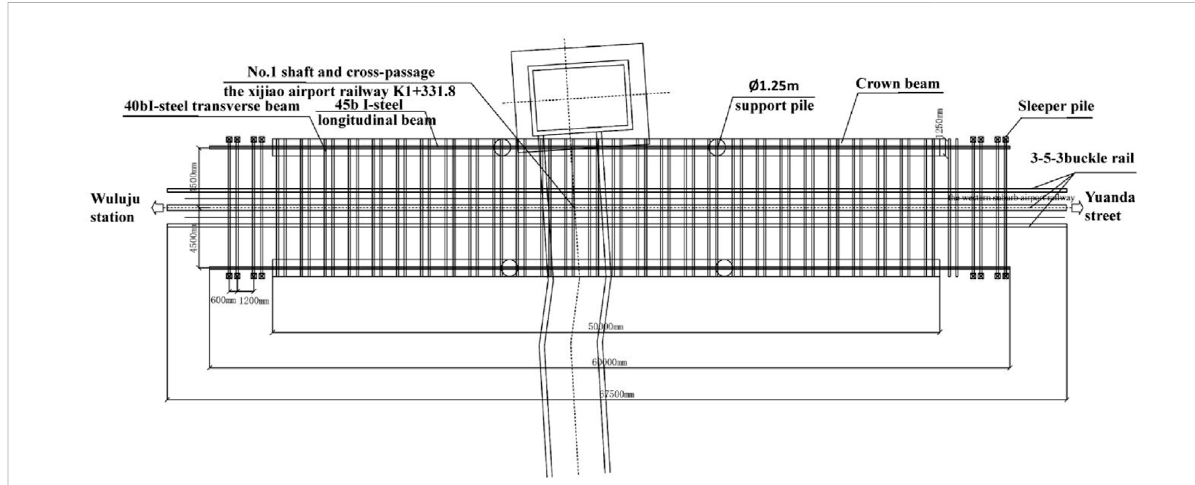
FIGURE 6 Rail reinforcement arrangement plane layout of No.1 passageway construction area.